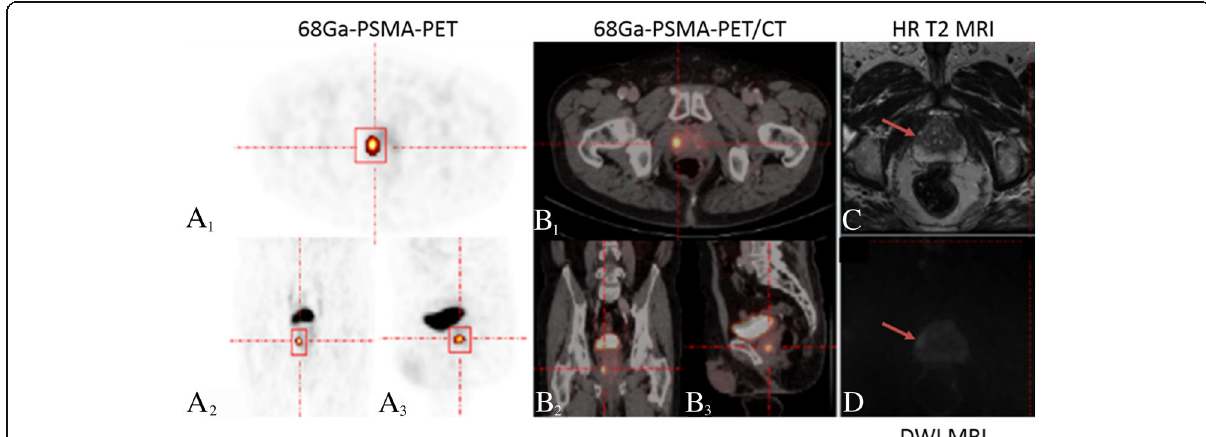
Fig. 1 Example of tumor heterogeneity for the asphericity assessment in a patient diagnosed with a Gleason score 6 prostate cancer. A – D Example of a patient diagnosed with a Gleason score 6 prostate cancer in the right peripheral zone of the apex of the prostate. A , B Corresponding orientations (transversal ( A 1 ), coronal ( A 2 ), and sagittal ( A 3 )) are shown for 68Gallium-labeled prostate-specific membrane antigen positron emission tomography, fused with computed tomography ( B 1 – 3 ). Based on positron emission tomography, an avid tumor was delineated in all three planes using the rover